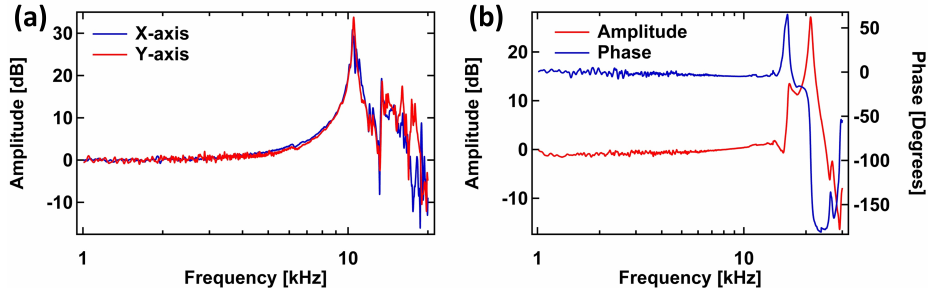
Figure 4. Frequency response of the ( a ) XY- and ( b ) Z-scanners.